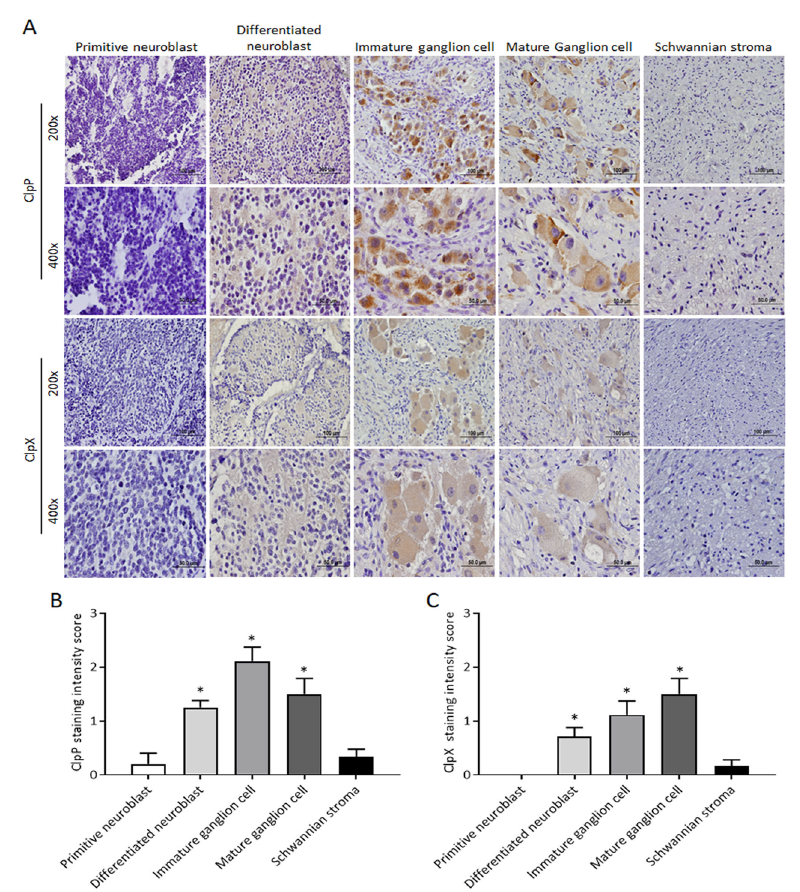
Figure 1. Comparison of ClpP and ClpX expressions in subtypes of human NBs: ( A ) Representative profiles of ClpP and ClpX immunostaining in differentiated NBs. ( B , C ) Histological scoring for ClpP and ClpX intensity in NBs tissues. Data in each bar chart are represented as mean ± SD. Primitive neuroblast ( n = 4), differentiated neuroblast ( n = 12), immature ganglion cell ( n = 10), mature ganglion cell ( n = 4), and Schwannian stroma ( n = 12). Upper panel, × 200 magnification, scale bar 100 µ m; lower panel, × 400 magnification, scale bar 50 µ m. * p <